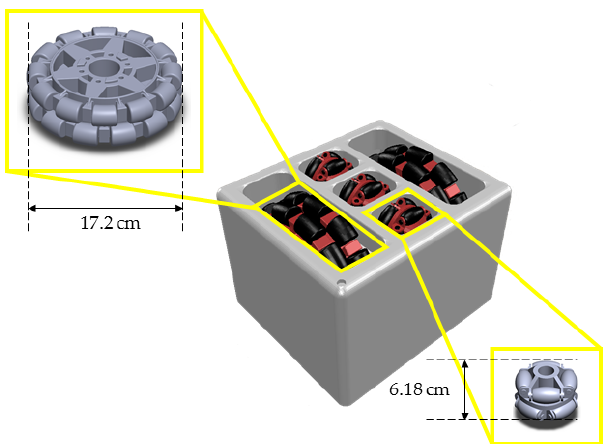
Figure 4. Physical appearance of one E-pattern omniwheeled cellular conveyor (EOCC) cell, which consists of big and small omniwheels.